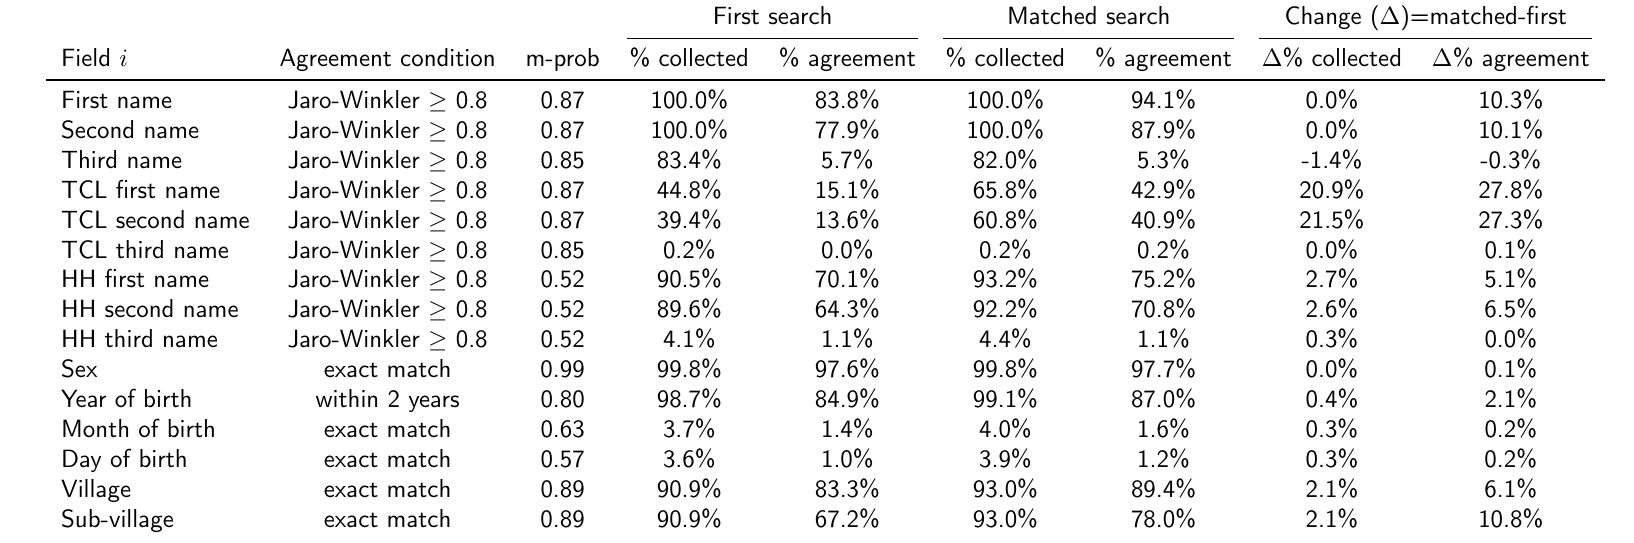
Supplemental Table 1: Agreement conditions, match (m) probabilities, proportion collected, and proportion of records with agreement for each field (i) in the probabilistic algorithm, by first and matched search attempts, n M